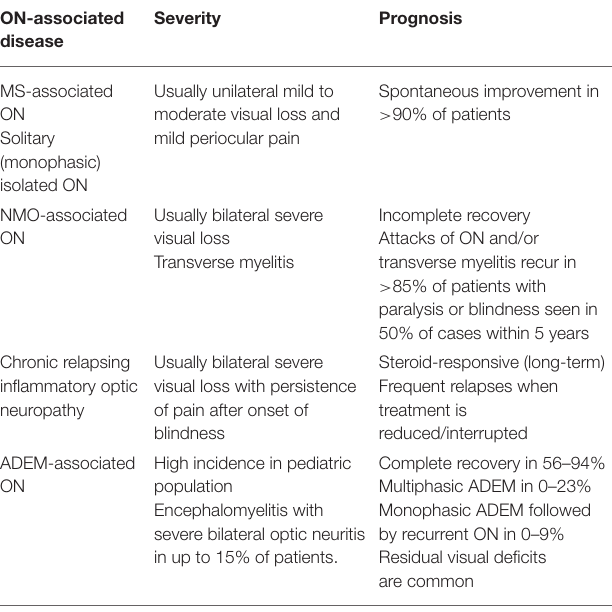
TABLE 3 | Severity and prognosis in human immune-mediated ON-associated diseases (68–71). ON-associated